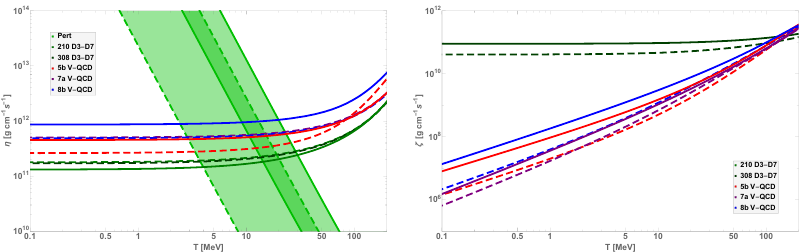
Figure 4. Shear (right) and bulk (left) viscosities from holography (curves) compared to perturbation theory (green band). The solid (dashed) curves are at µ = 450 MeV (600 MeV). Figures from [63,